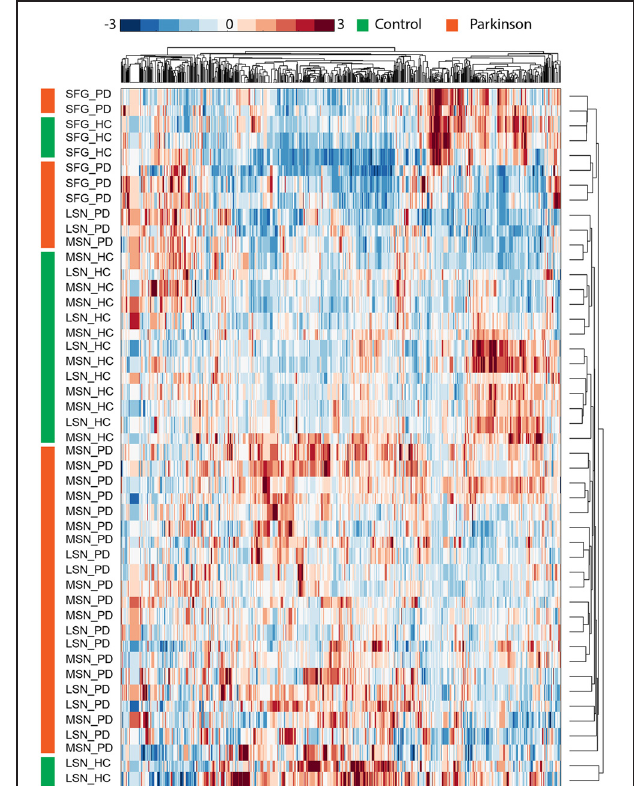
FIGURE 4 | Brain expression levels of spliced transcripts classify PD patients from control volunteers in a brain-region dependent manner. Shown is a hierarchical classification in the noted brain regions of those same transcripts found to be alternatively spliced in PD leukocytes. Note that the hierarchical classifier successfully classified patients from healthy control volunteers based on expression levels obtained by 3 (cid:2) microarrays interrogating three post mortem brain regions: superior frontal gyrus (SFG), medial substantia nigra (MSN) and lateral substantia nigra (LSN). Each row corresponds to one probe set interrogating a gene that was detected as alternatively spliced in leukocytes from patients and each column represents one sample of brain transcriptome from either patient (red) or healthy volunteer (green) from the independent cohort (Moran et al., 2006). The frontal brain region was correctly segregated from both substantia nigra regions by the expression data, and overall 43 of the 47 samples ( ∼ 91.5%) were correctly classified as healthy or Parkinsonian